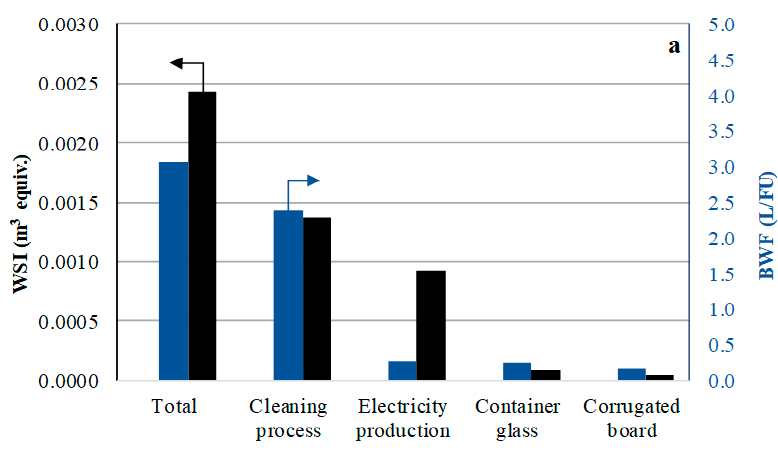
Table 5. Wine water footprint components for both case studies and